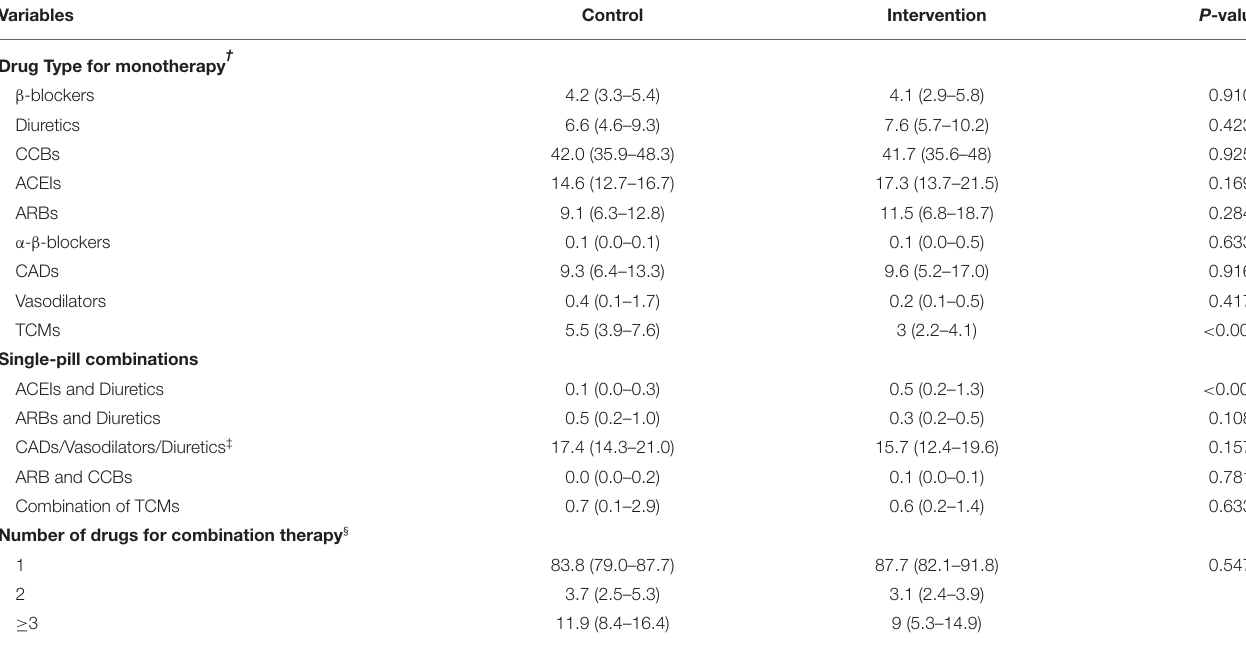
TABLE 3 | Antihypertensive medicine use in participants with hypertension. Variables Control Intervention P